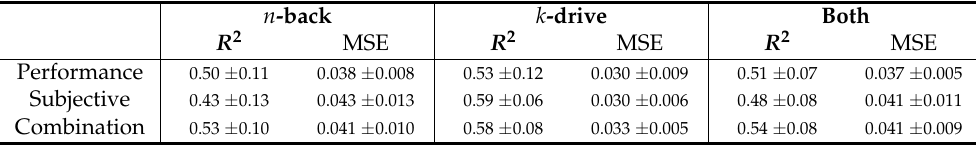
Table 11. MSE and R 2 score of regression tasks using performance measures, subjective feedback and the linear combination of both as the target value for n -back, k -drive and the combination of both experiments. n -back k